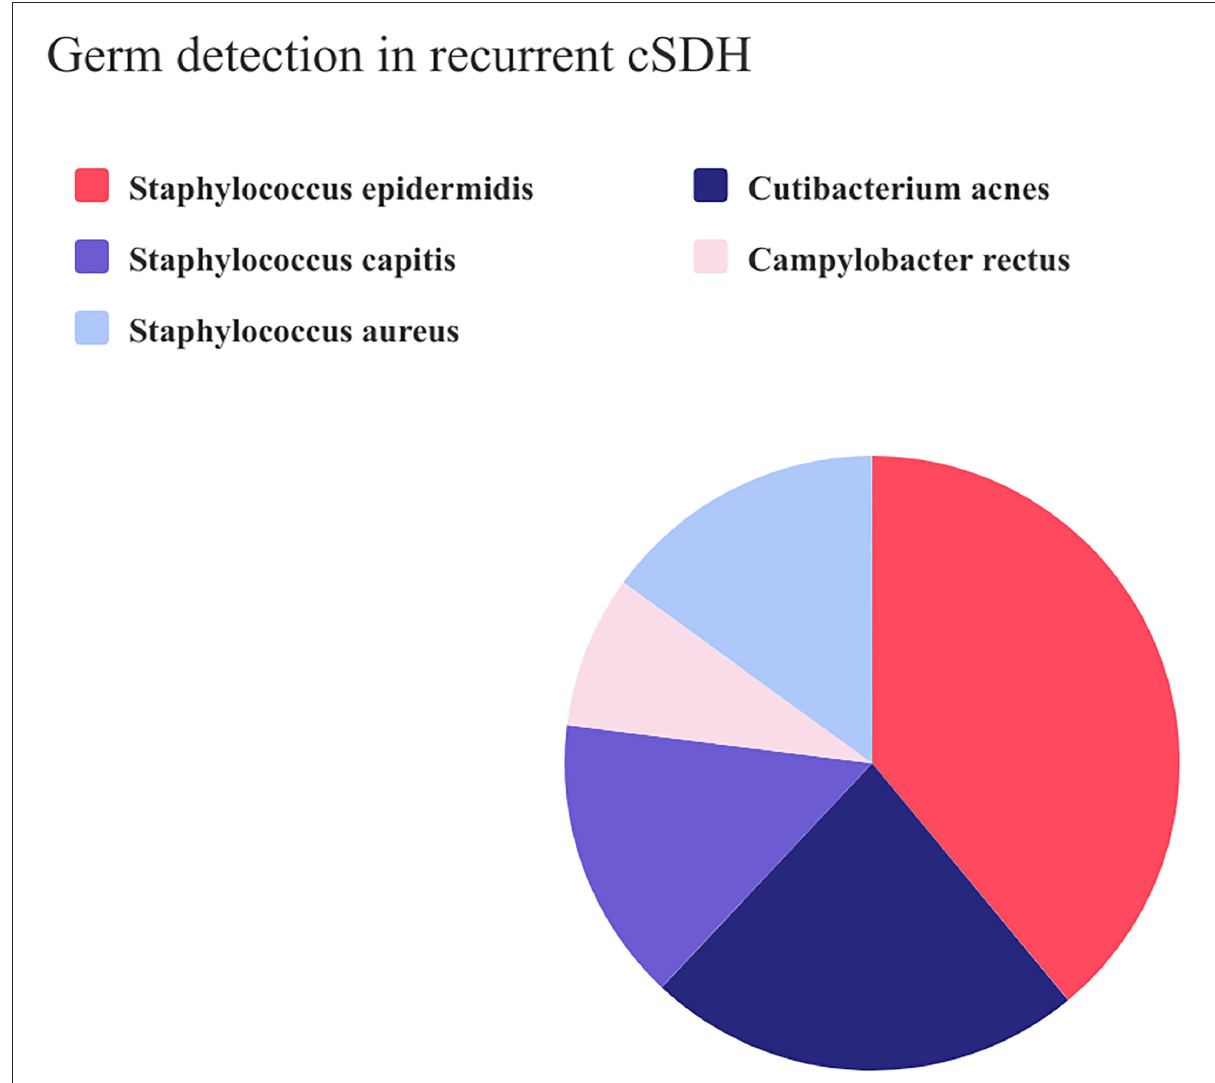
FIGURE2 Pie chart composition of the positive microbiological swab results in recurrent